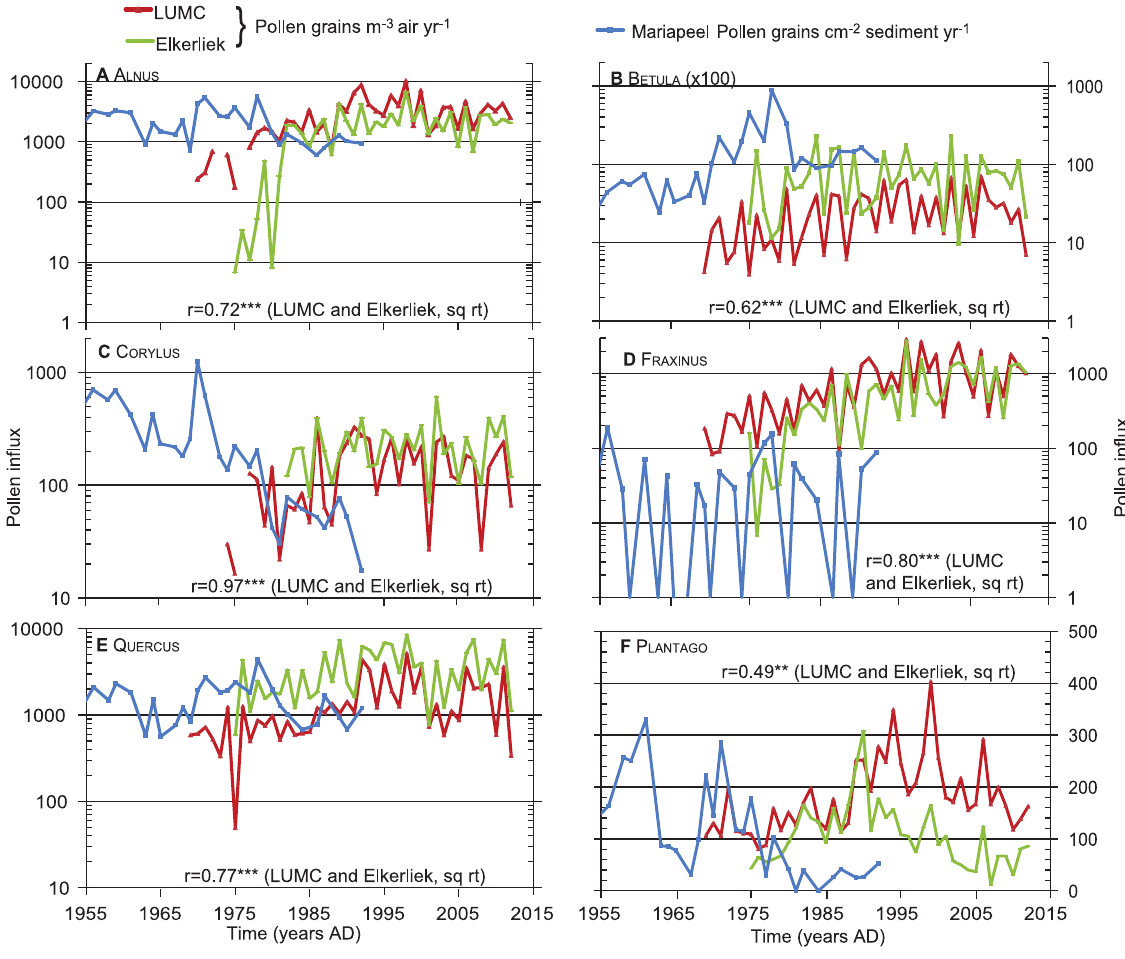
Figure 4. Annual pollen influx values 1969–2012 for LUMC, Elkerliek (n m 2 3 air yr 2 1 ) and Mariapeel (n cm 2 2 sediment yr 2 1 ). Values are shown for (a) A LNUS , (b) B ETULA , (c) C ORYLUS , (d) F RAXINUS , (e) Q UERCUS , and (f) P LANTAGO . Note that a–e are on a logarithmic y-axis.